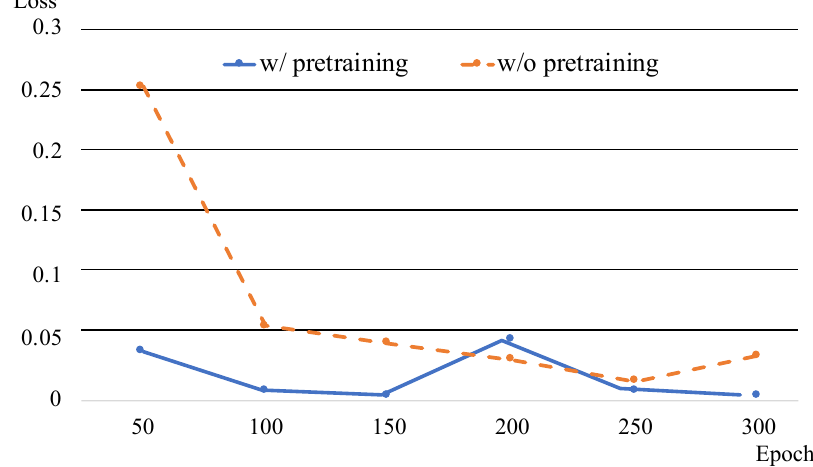
Figure 7. Variation of the loss with pretraining and without pretraining.